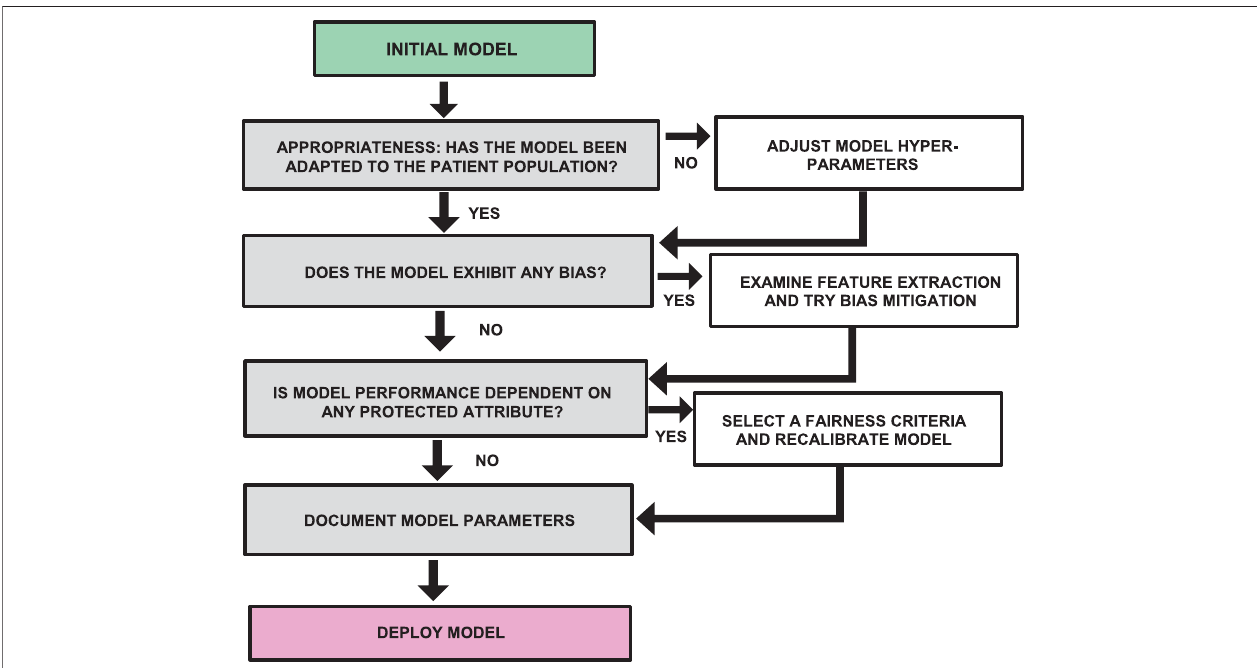
FIGURE 3 | Work fl ow diagram showing steps required to examine a model for bias, fairness and appropriate use before